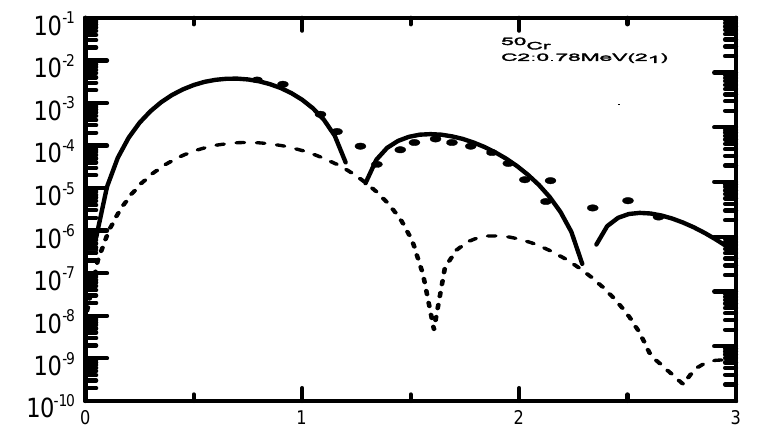
1 0 - 1 0 1 2 3 Fig.1: Inelastic longitudinal form factors for the transition to the and without core-polarization effects, the experimental data are taken from Ref.[16].